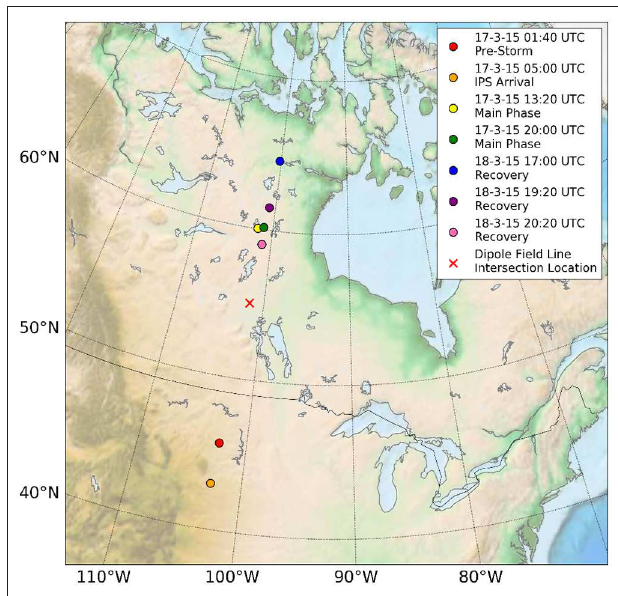
5 R E ˆ X during various −